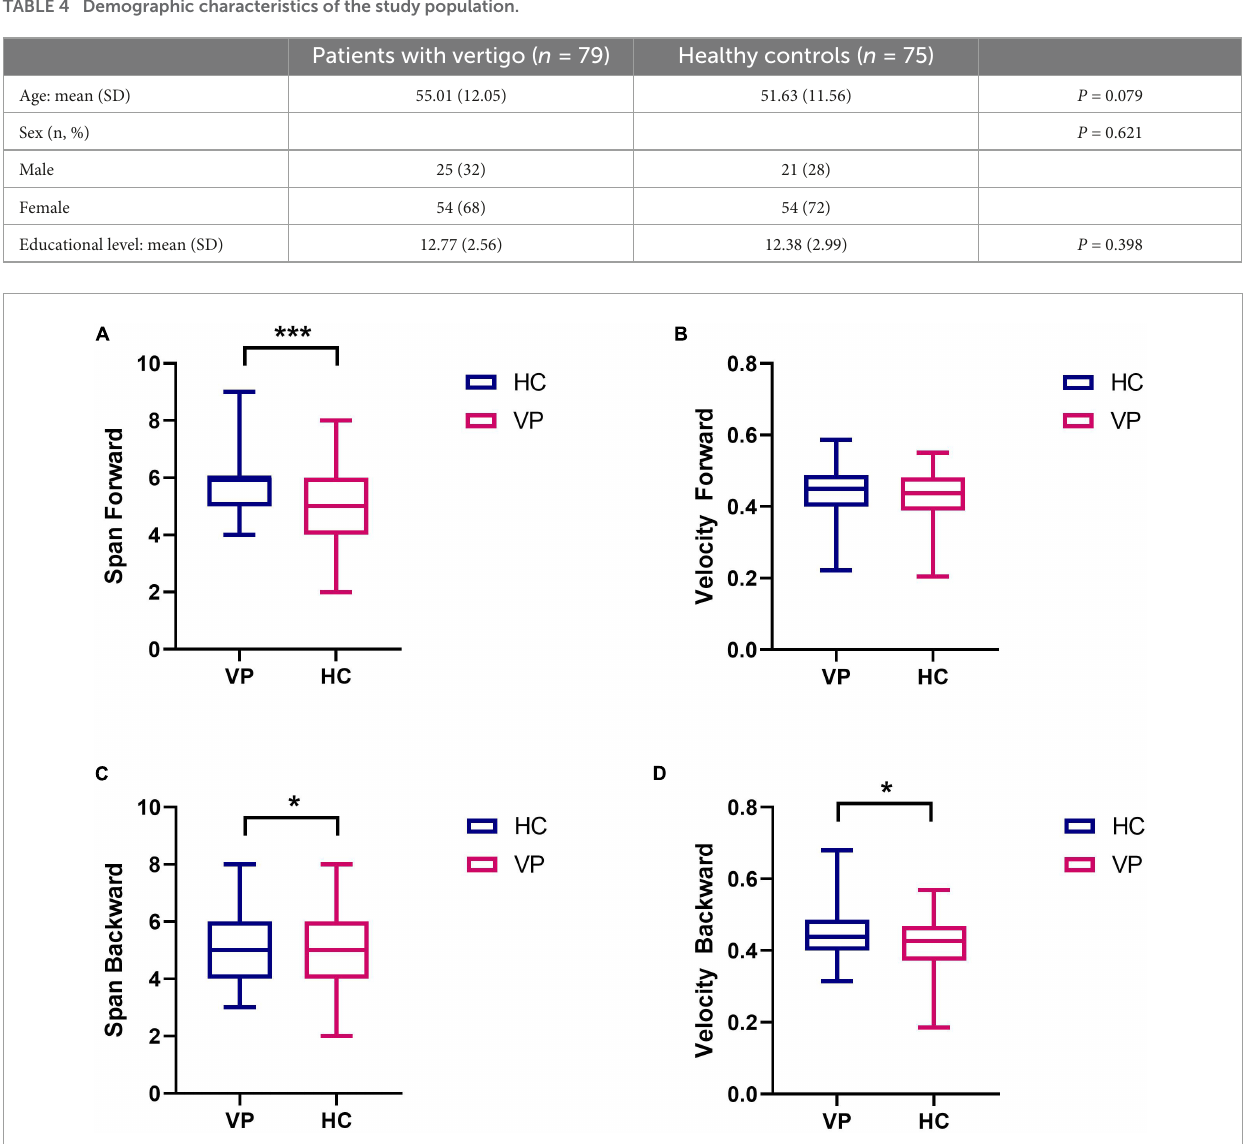
FIGURE10 Comparison of weeding test indexes between VP and HC. (A) Span forward. (B) Velocity forward. (C) Span backward. (D) Velocity backward. The upper and lower lines represent the 95th and 5th percentiles, respectively, and the horizontal line within the box is the median. VP, patients with vertigo; HC, healthy controls. *** P < 0.01, * P <